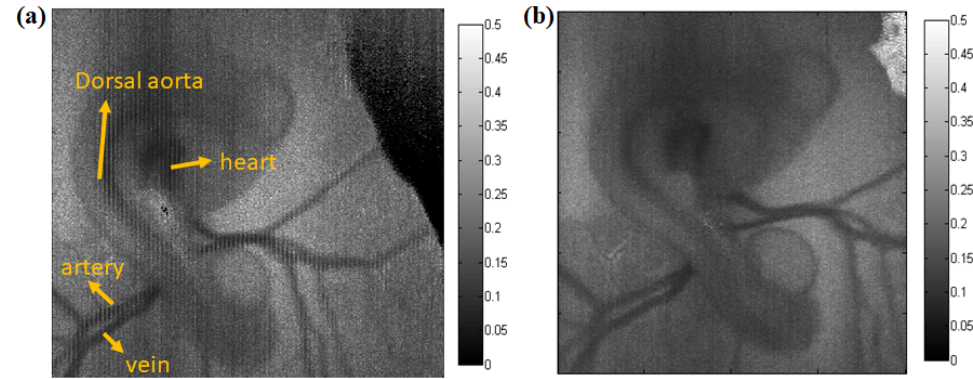
Figure 5. The laser speckle contrast images of a chick embryo (day 3.5) under the exposure time 4 ms using the ( a ) LS-TSCI; ( b ) LS-SSCI. The image area is 10.24 mm × 8.64 mm.